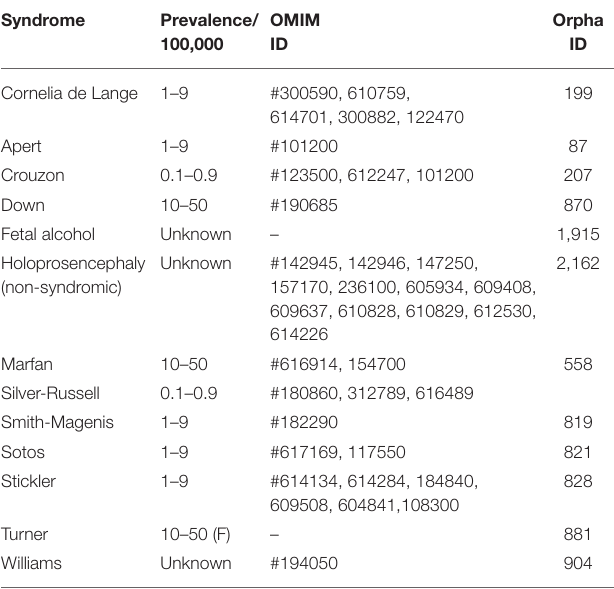
TABLE 2 | Syndromes affecting craniofacial and dental structures below cut off, as not meeting the three inclusion criteria of this review.